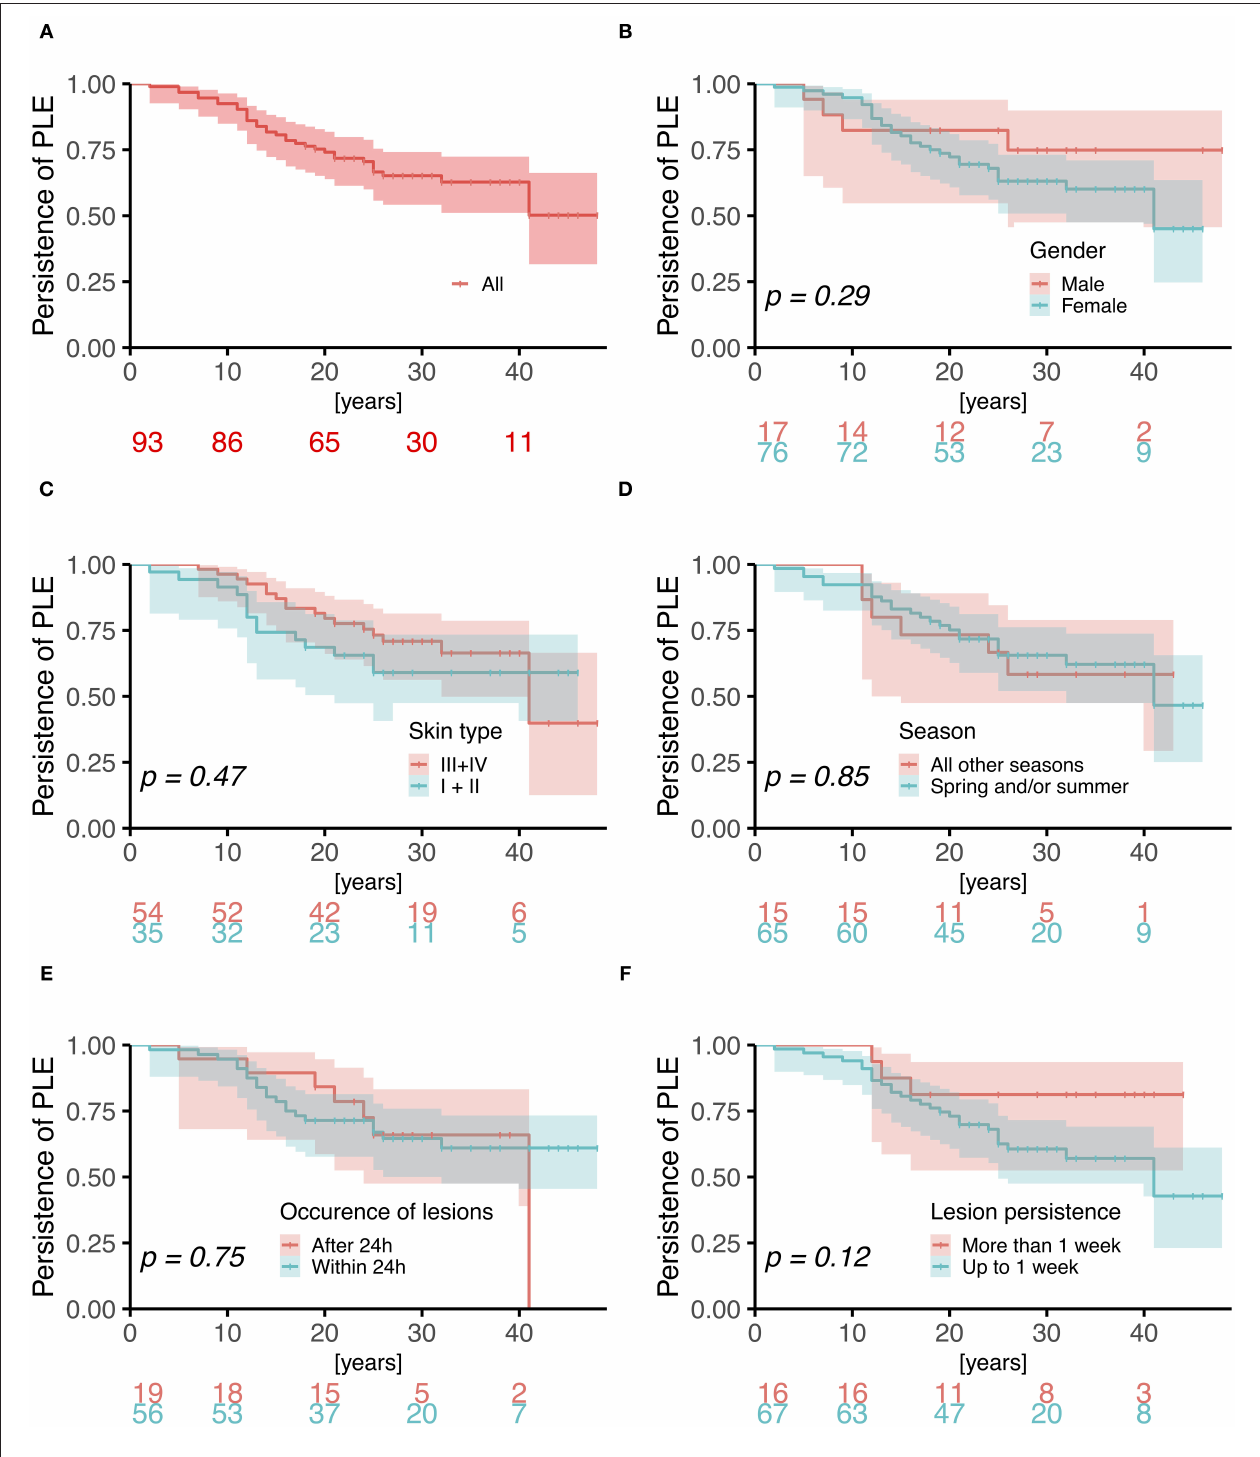
FIGURE 3 | Kaplan-Meier analysis of persistence of PLE. Log-rank p -values are blotted in the individual graphs for (A) all patients and comparing (B) male vs. female gender (hazard ratio 1.75; 95%CI, 0.62–4.97), (C) skin phototype III/IV vs. I/II (1.29; 0.64–2.61), (D) PLE lesions during all seasons vs. spring/and or summer (0.92; 0.38–2.26), (E) occurrence of lesions after 24h vs. within 24h (0.86; 0.38–1.96), and (F) lesion persistence of more than 1 week vs. up to 1 week (2.47; 0.75–8.13).